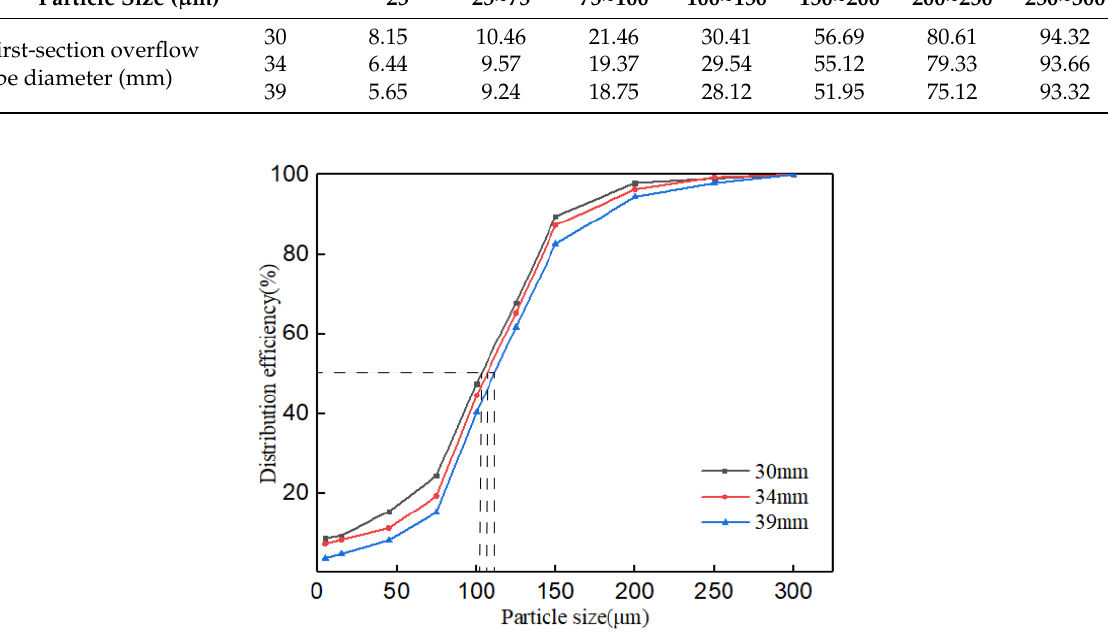
Figure 9. Effect of the first-section overflow pipe diameter on classification efficiency.